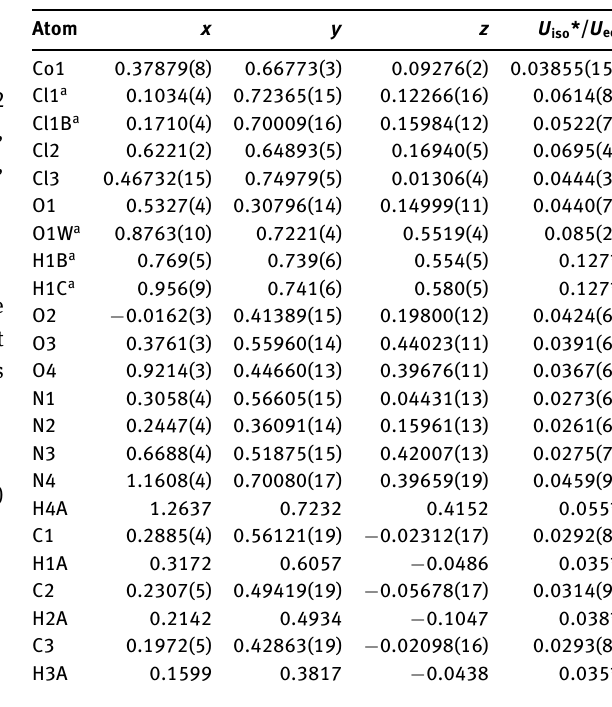
Table 2: Fractional atomic coordinates and isotropic or